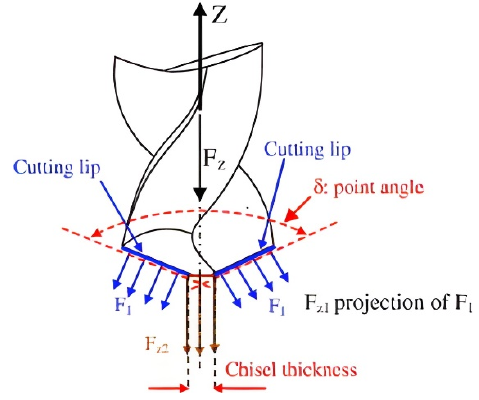
Figure 6. Decomposition of thrust force